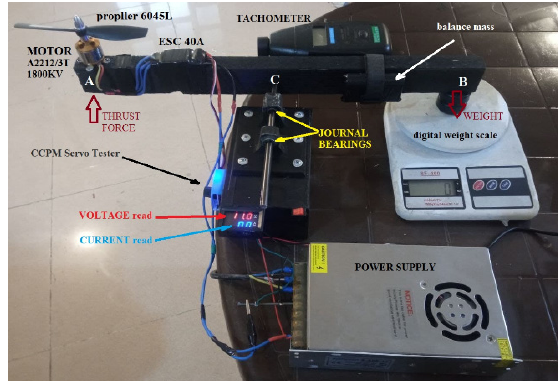
Figure 3. The developed test rig to find the characteristics of the used motor and propeller